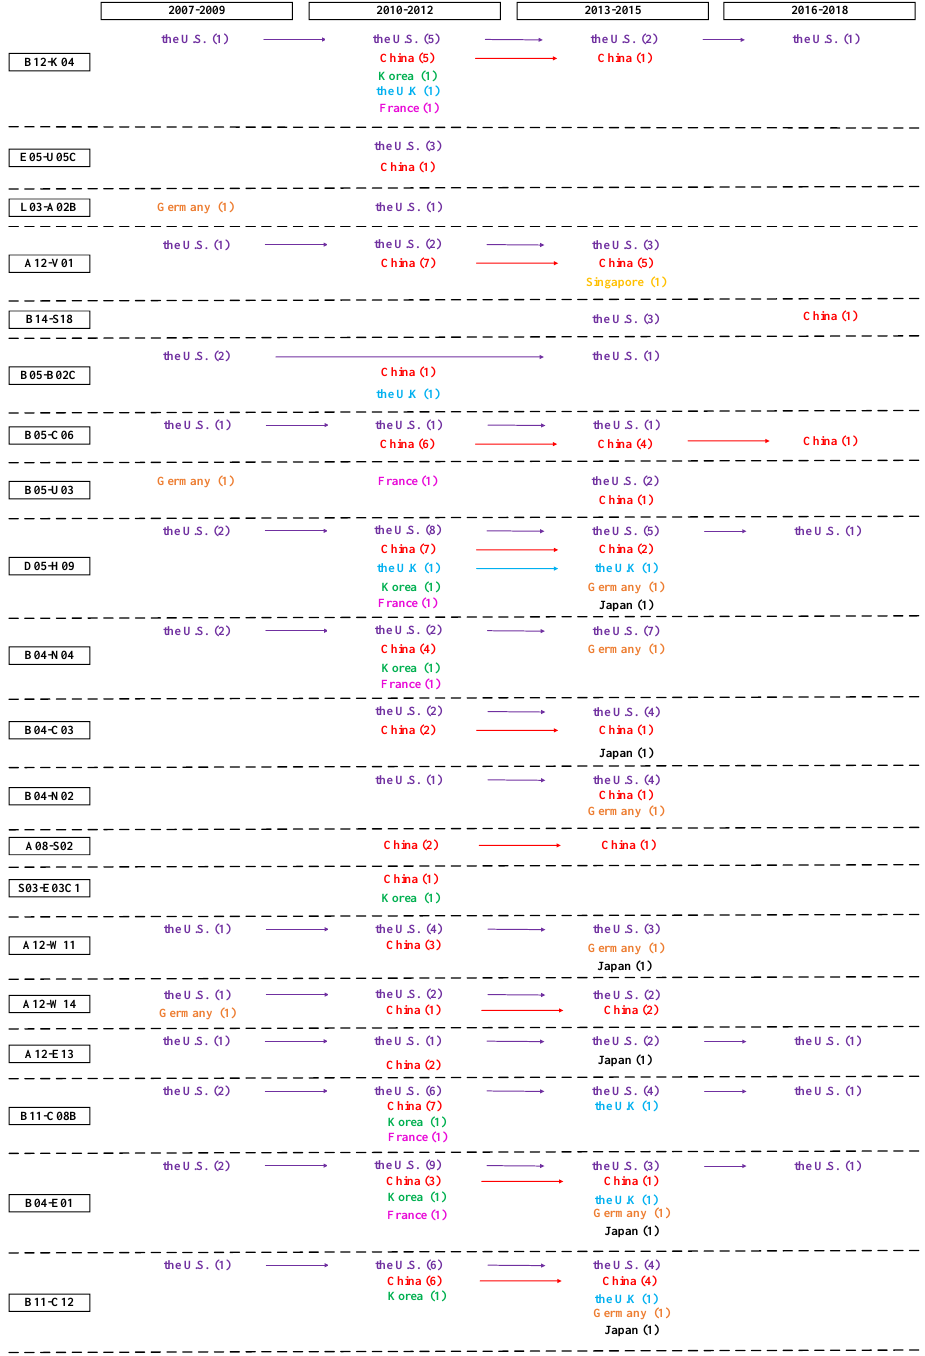
Figure 4. Country level patent roadmap of graphene biomedical technology.